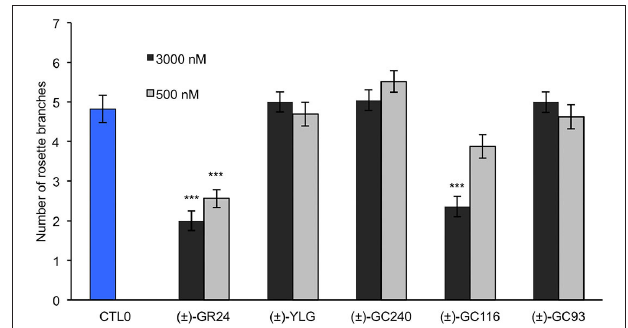
FIGURE 6 | Bioactivity in Arabidopsis of probes vs. ( ± )-GR24 ( max3-11 ). Number of rosette branches of mutant plants max3-11 grown in long-day conditions. These data were obtained from means ± SE ( n = 12 plants). *** P < 0.001 indicate significant differences with the control treatment (0nM) (CTL0) (Kruskal–Wallis rank sum test). CTL0, control